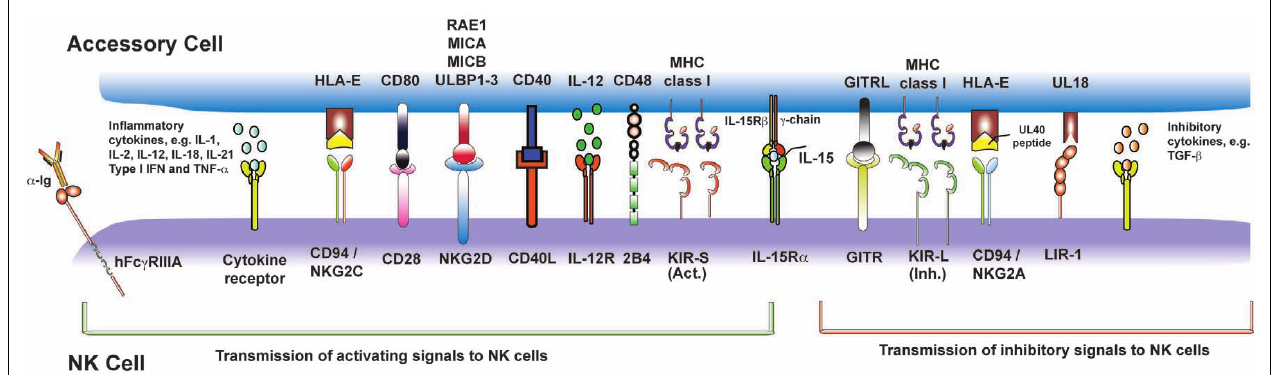
contact-dependent and -independent) to activating receptors on NK cells (in purple, below).This figure summarizes those for which there is the strongest experimental evidence, but is not